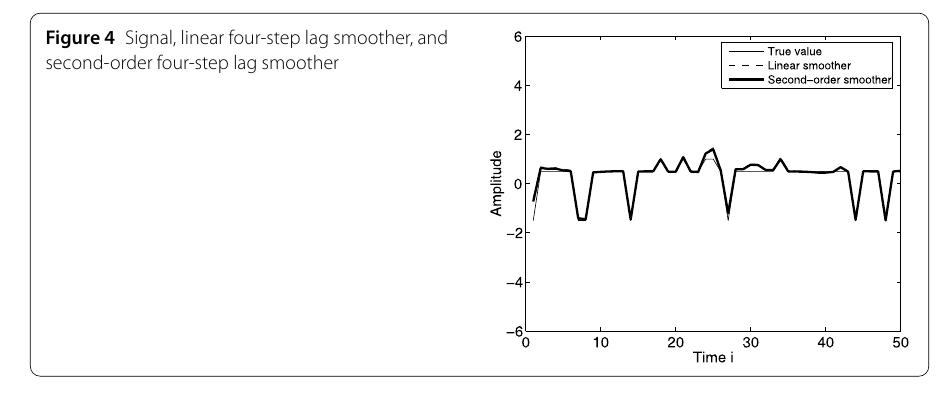
Figure 5 Linear four-step lag smoother error and second-order four-step lag smoother